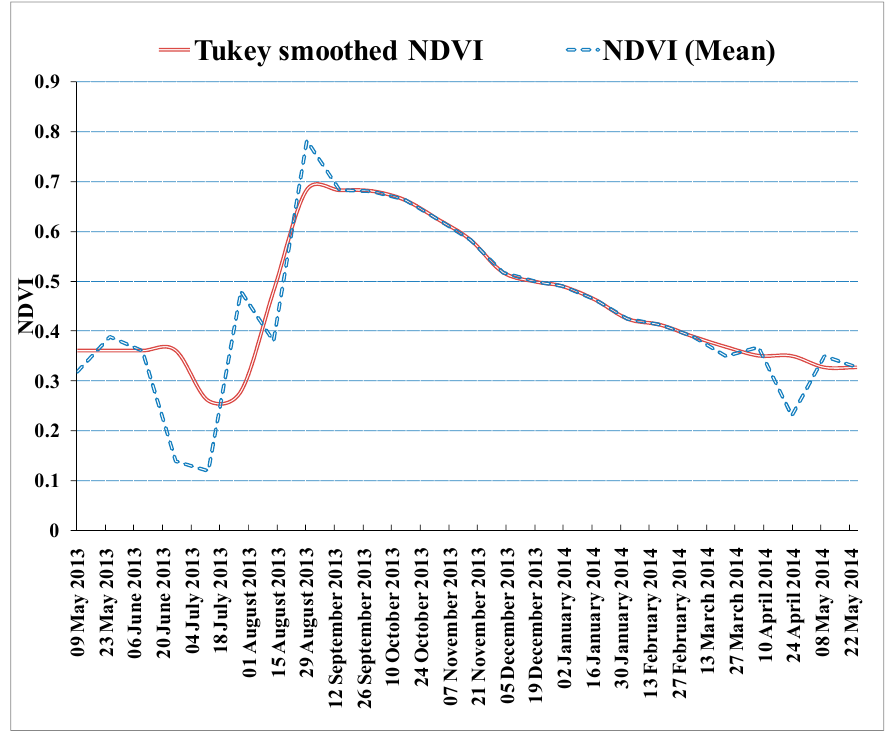
Figure 9. Raw MODIS NDVI and TS-smoothed reconstructed NDVI time series of year 2013–2014 for derivation ofend of the season in Tectona grandis indicated by orange arrow.